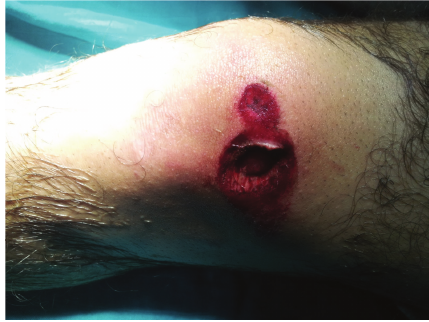
Figure 1: Parapatellar internal wound secondary to crushing.